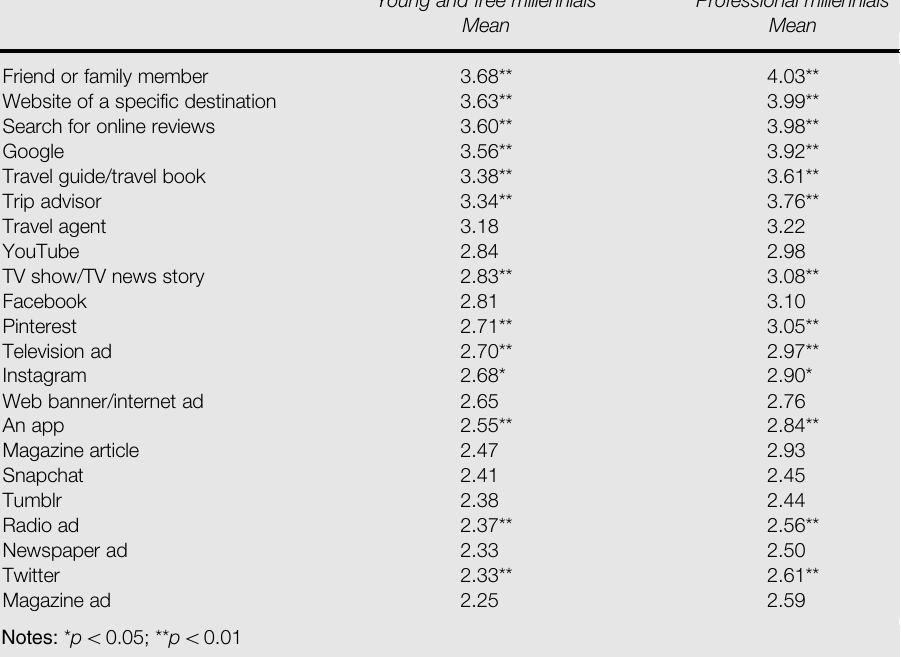
Table VI Travel medium